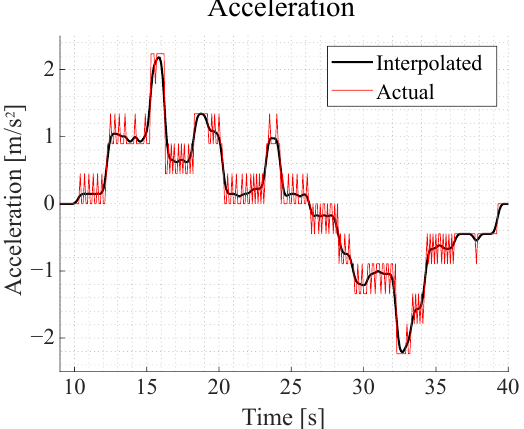
Figure 5. Difference in acceleration before ( red ) and after ( black ) data processing. Interpolation provides a more linear and realistic speed profile.